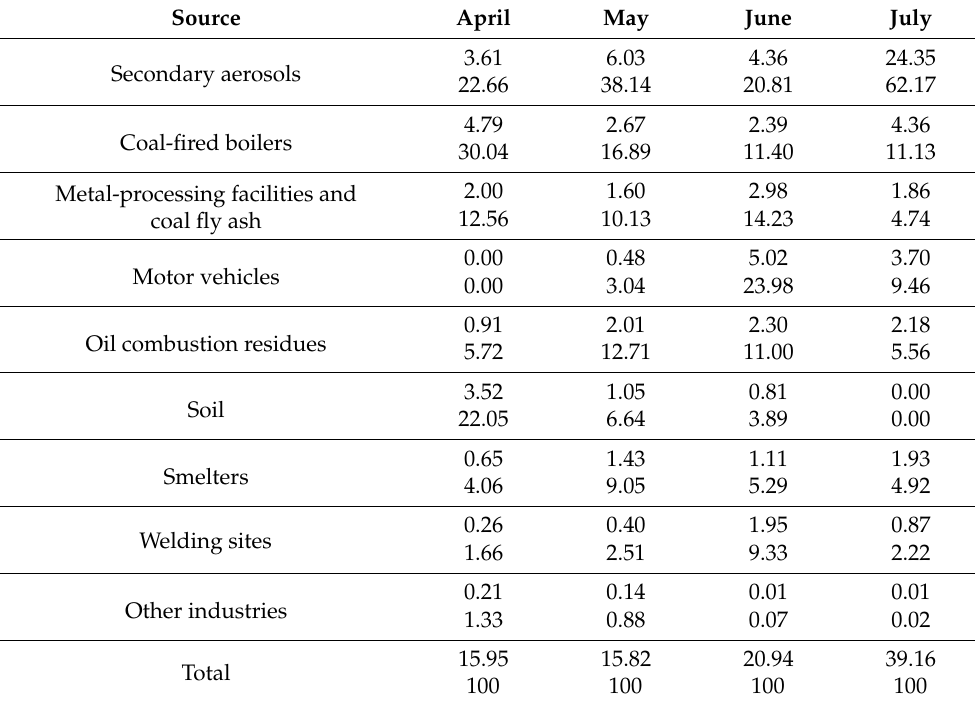
Table 4. Contribution of each pollution source by month (unit: µ g/m 3 ,